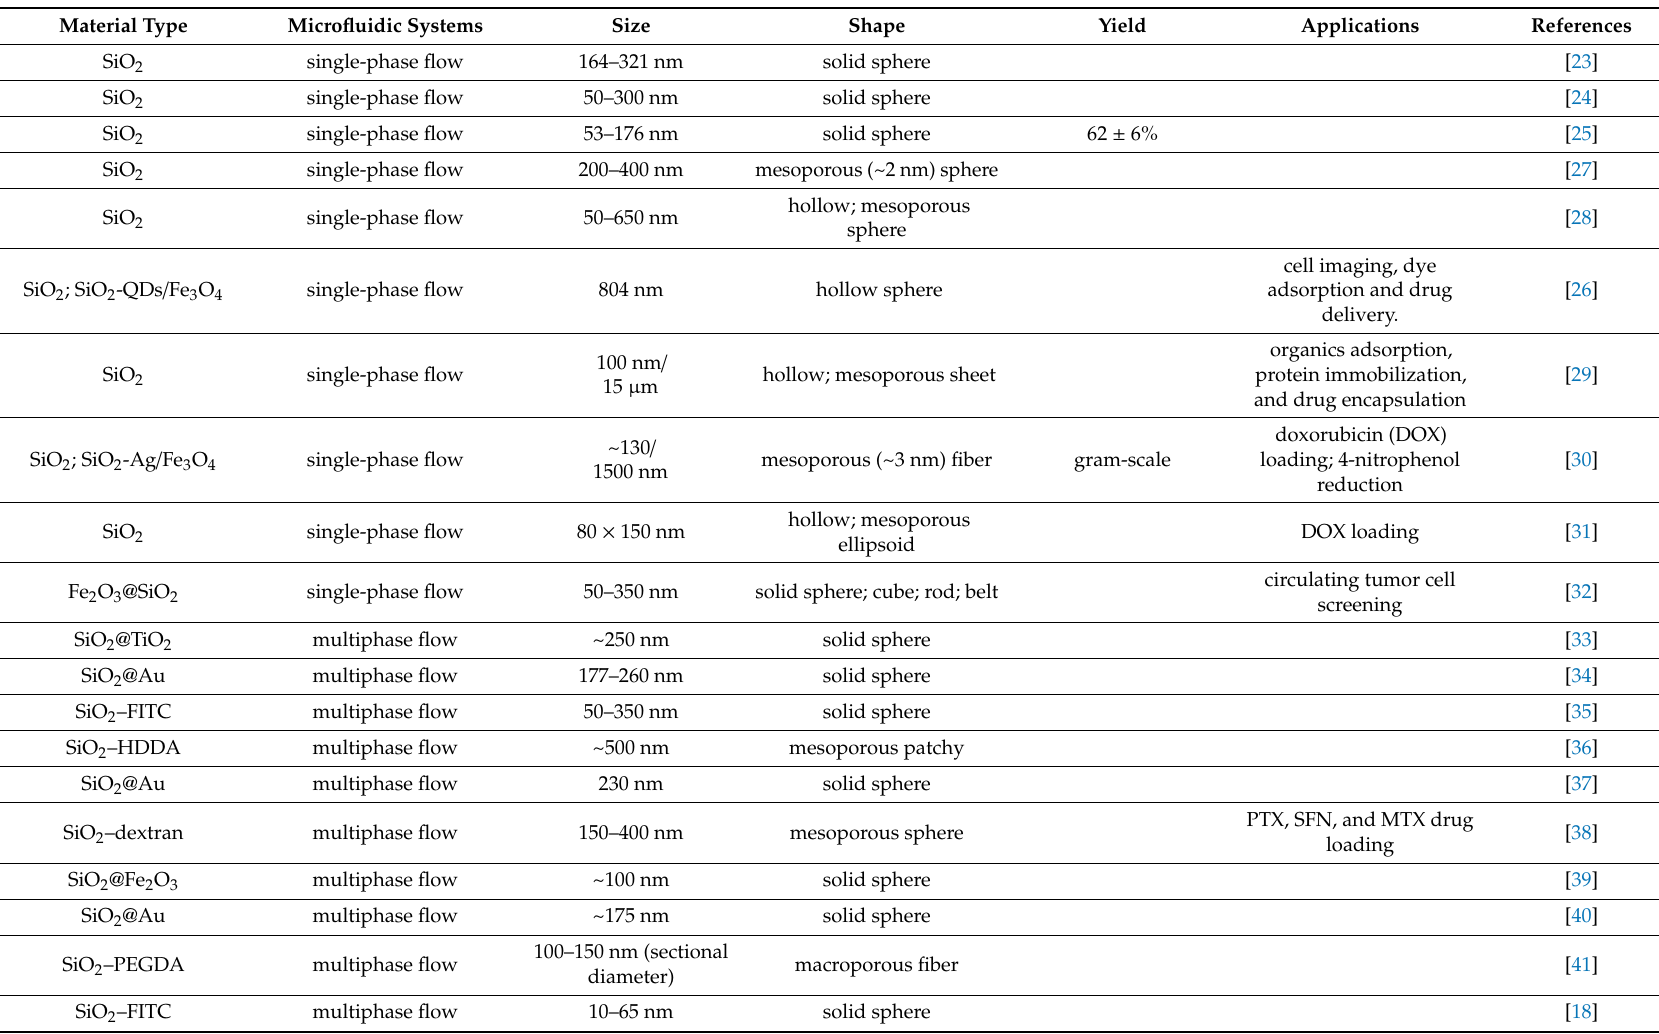
Table 1. Inorganic nanomaterials synthesized by microfluidics as well as their structural characteristics, yields, and